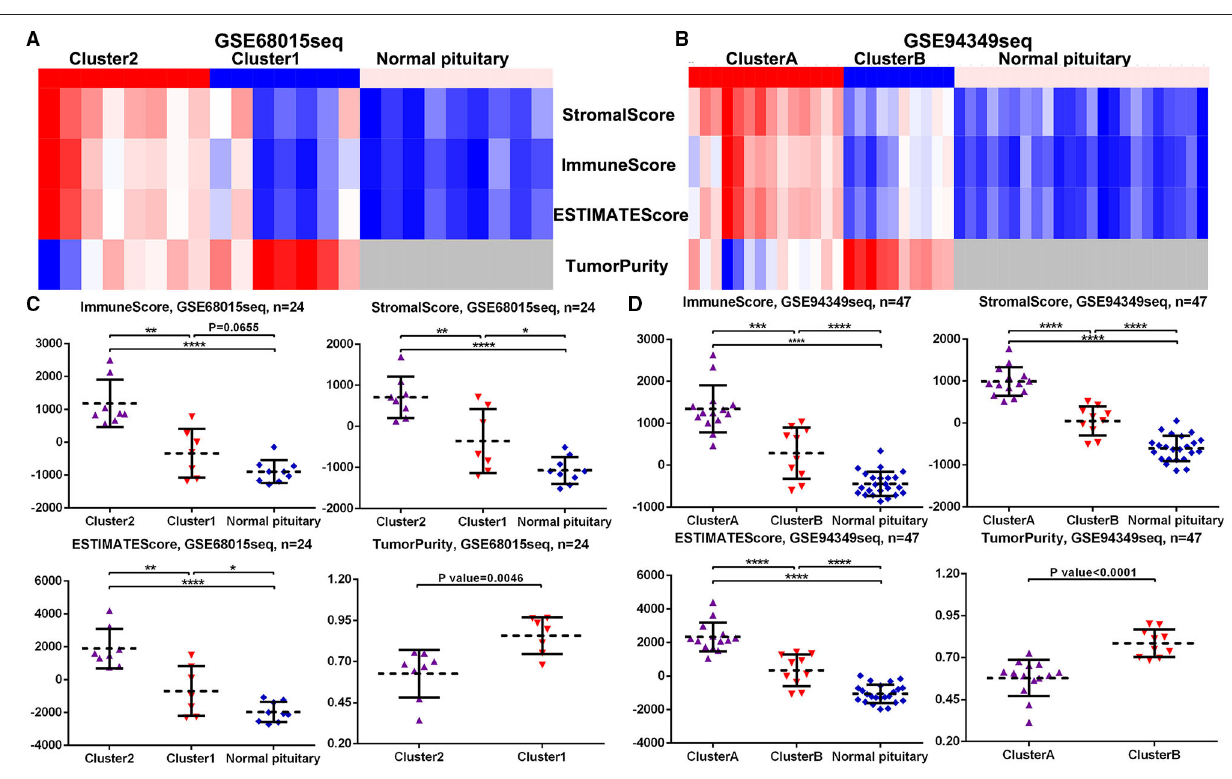
Frontiers in Neurology | www.frontiersin.org